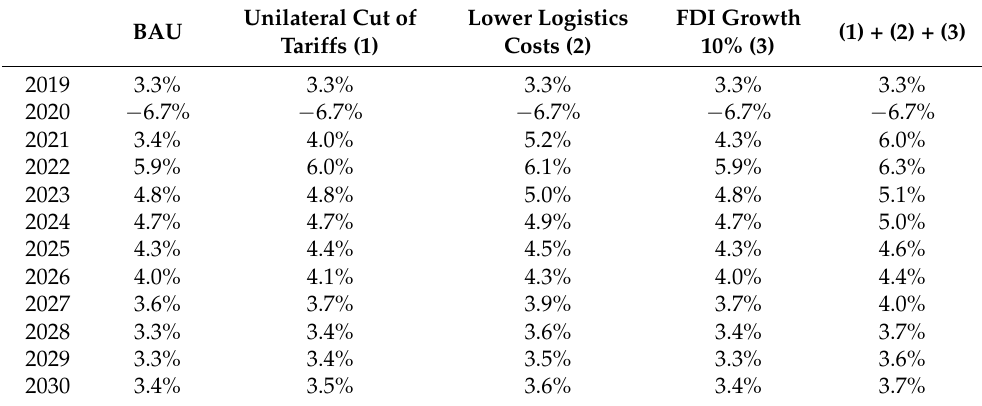
Table 6. GDP growth projections from CGE simulation with Global Value Chain (GVC) reforms.